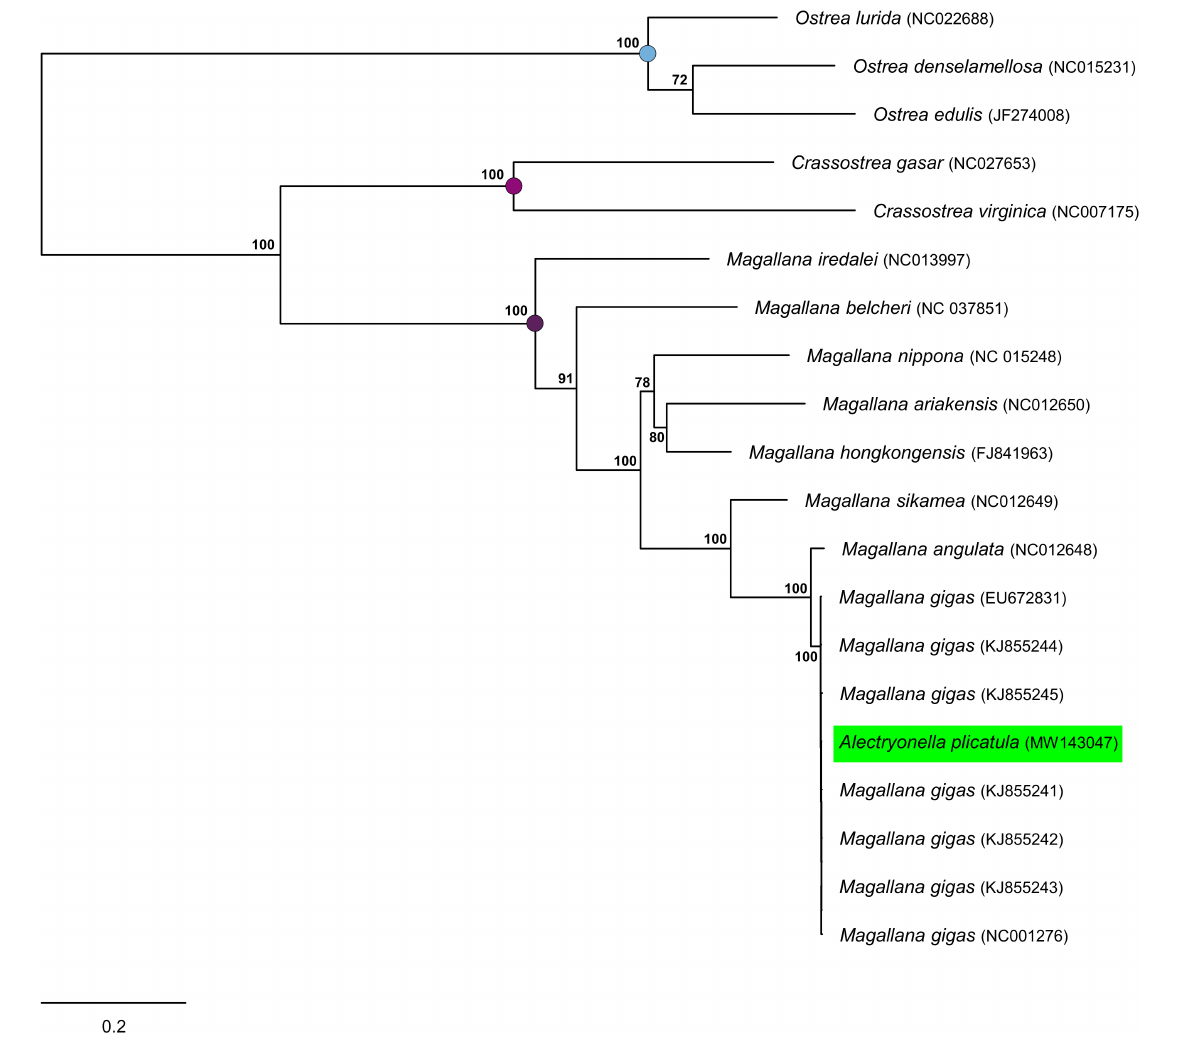
FIGURE 2 | Maximum Likelihood tree based on the concatenated sequences of 12 protein-coding genes from complete mitochondrial genomes of the same oyster taxa analyzed by Wang et al. (2021) plus six additional mitogenome sequences of Magallana gigas . Bootstrap values are reported in correspondence of main nodes. The mitogenome MW143047 is nested within the clade formed by mitogenomes of M. gigas